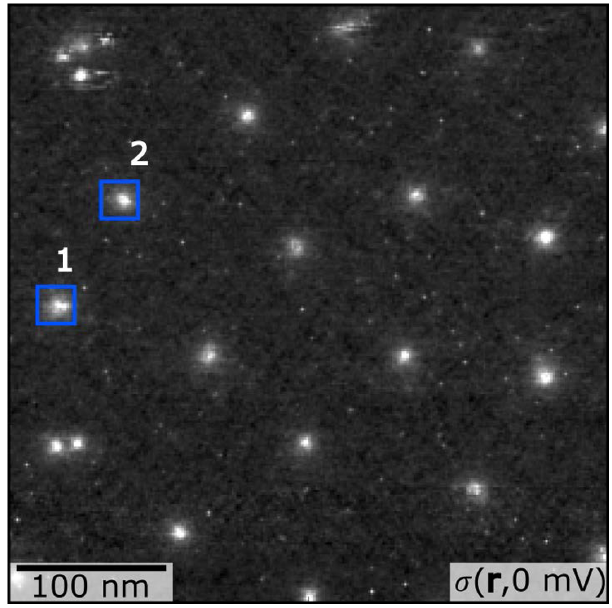
FIG. 3. 500 × 500 nm 2 STS conductance map of OD Bi2212 ( T c ≈ 52 K) revealing a disordered lattice with a vortex density corresponding to an applied magnetic field of about 0.16 Tesla. Vortex 1 and vortex 2 are further investigated in Figs. 2 and 4,